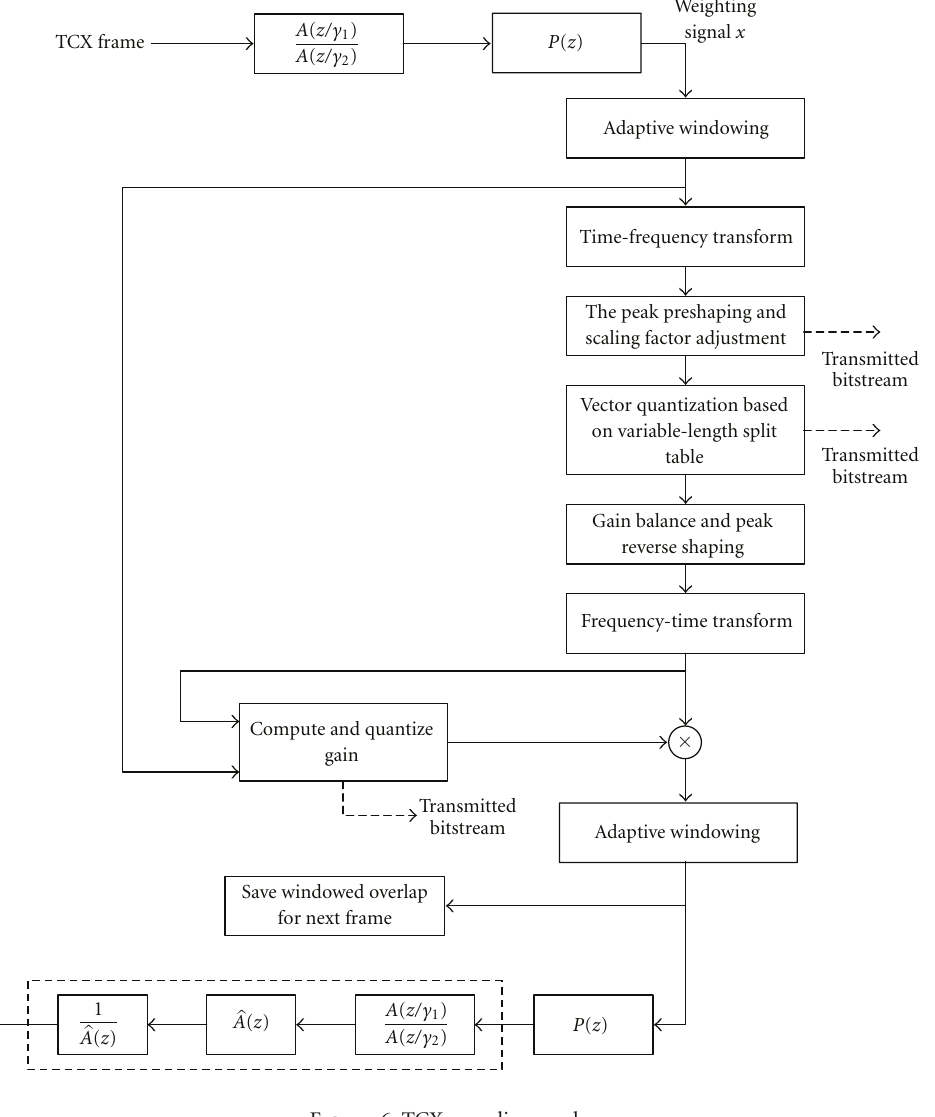
Figure 6: TCX encoding mode.